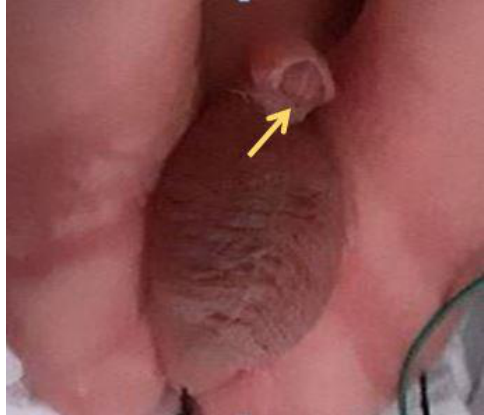
Figure 4. A ventrally bent penis with first degree hypospadias.